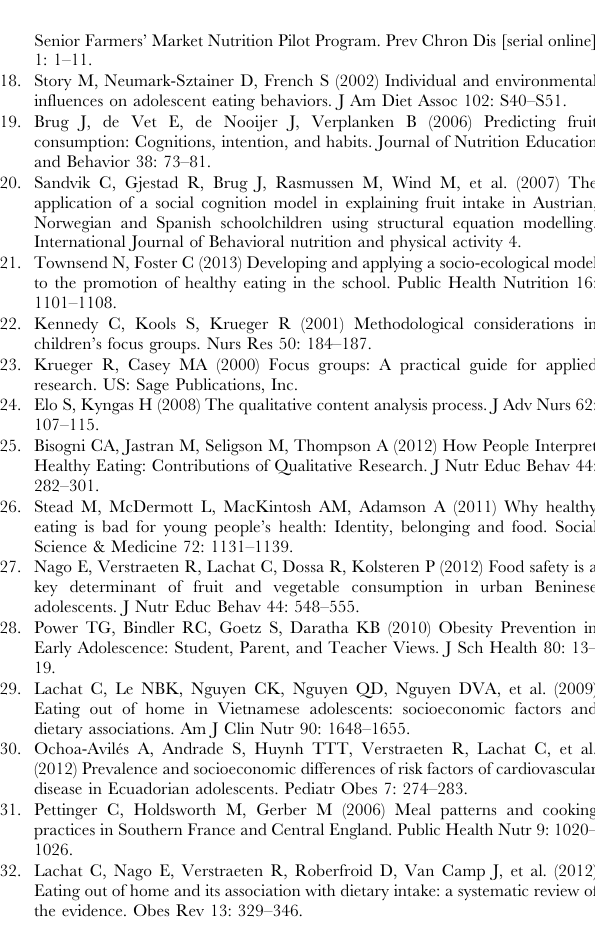
Table S2 Quotes on environmental factors influencing eating behavior in adolescents, parents and school